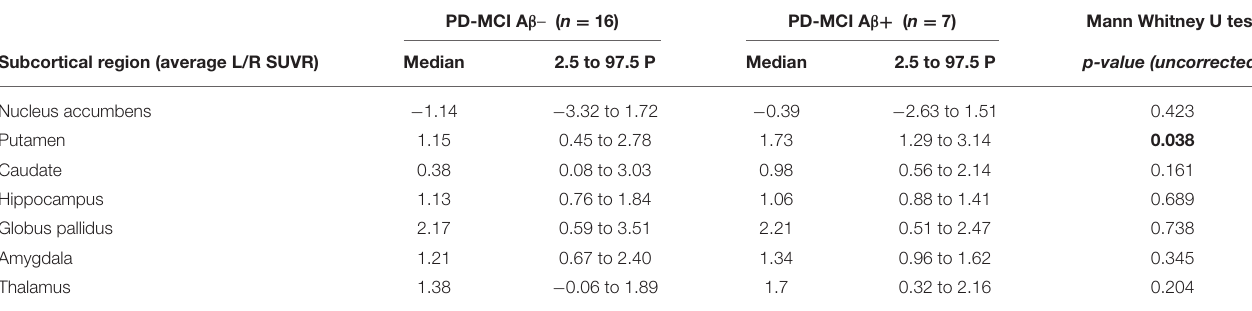
TABLE 4 | Pattern of β -amyloid striatal and extra-striatal subcortical